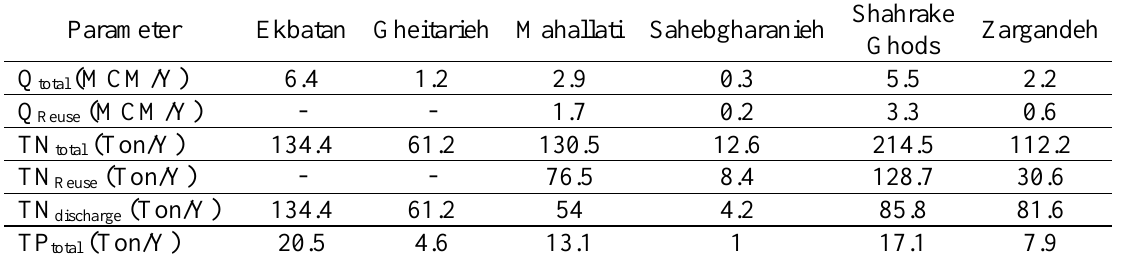
Table 5. The total nutrients load discharged or reused for wastewater treatment plants